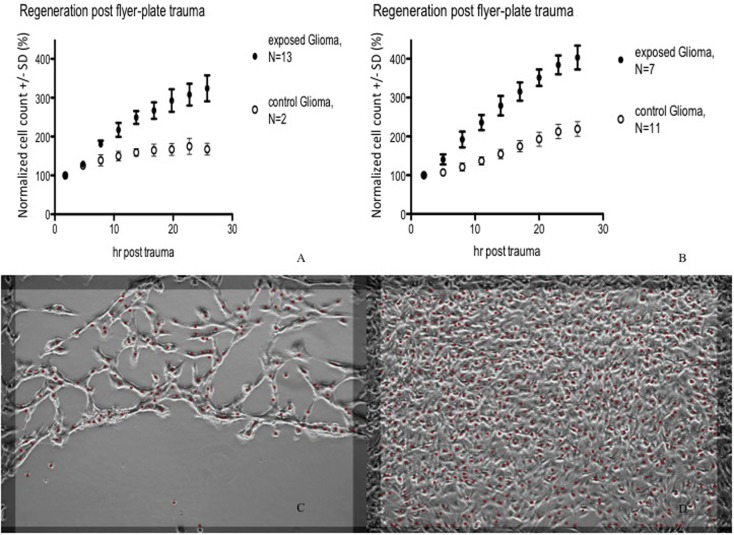
Cell count (normalized mean ± SD) in lesion peripheries vs. control-colonies of glioma. Trauma exposures in two different sets of measurements (A,B) are shown. Micrographs of live glioma – first (C) and last (D) images post trauma – illustrating growth at the lesion periphery. The red dots indicate counted cells. Original magnification 10×.